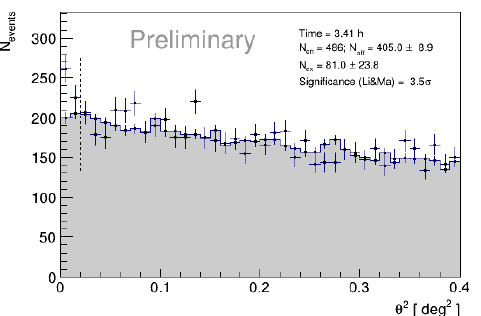
Figure 26. GRB201015A: distribution of the angular distance θ 2 between the reconstructed event arrival directions and the nominal source position. The gray histogram represents background events while the black point with blue crosses are the γ -like events. The vertical dashed line describes the θ 2 cut value and defines the region in which excess events and signal significance are calculated. From